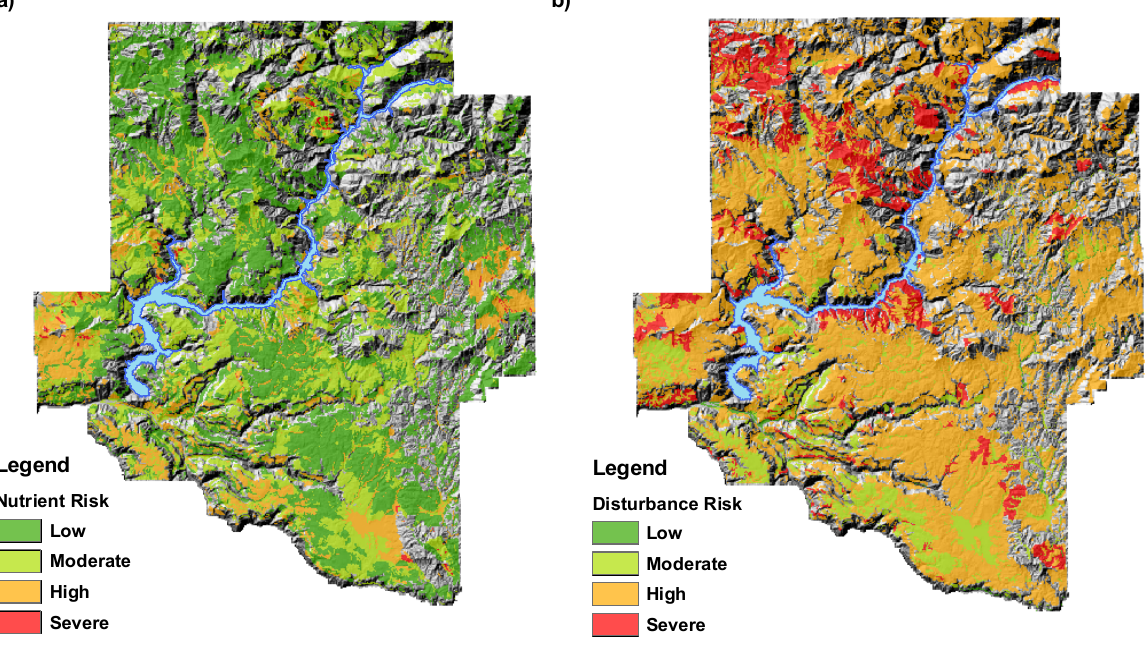
Table 3. NRCS soil erosion hazard as a function of slope and the soil erosion factor K the ID612 survey area of the Northern Rockies ecoregion, USA [41]. Soil Erosion Hazard Slight (1) Moderate (2) Severe (3) Very Severe (4) K w† Slope (%) K < 0.35 0–14 15–35 >50 w K ≥ 0.35 0–9 >40 w